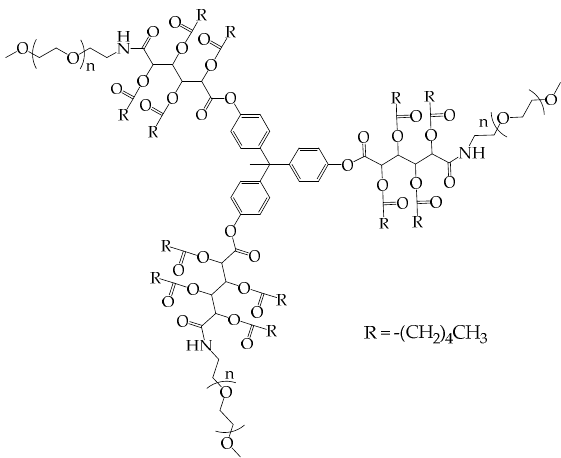
Figure 4. Multi‐arm polymers based on a poly‐alkylated hydrophobic core and a pegylated hydrophilic shell . Reproduced with permission from reference [29], Royal Society of Chemistry, 2000.